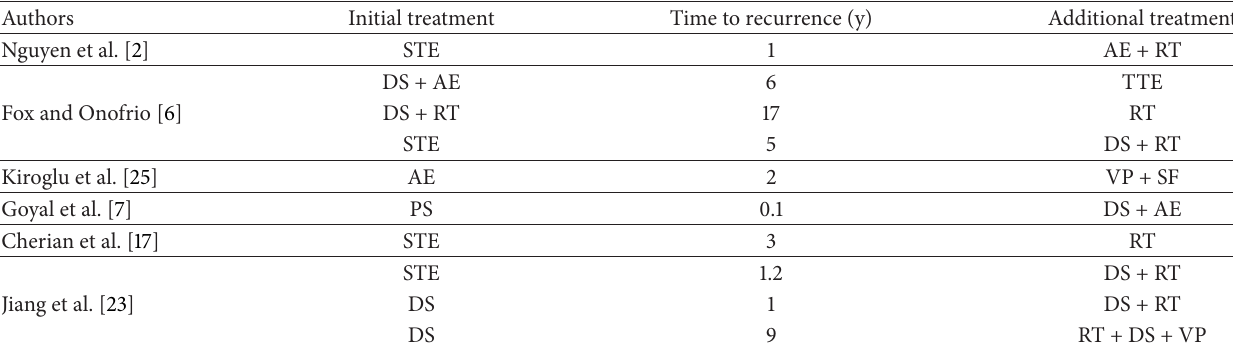
Table 1: Cases of hemangioma recurring after initial treatment.